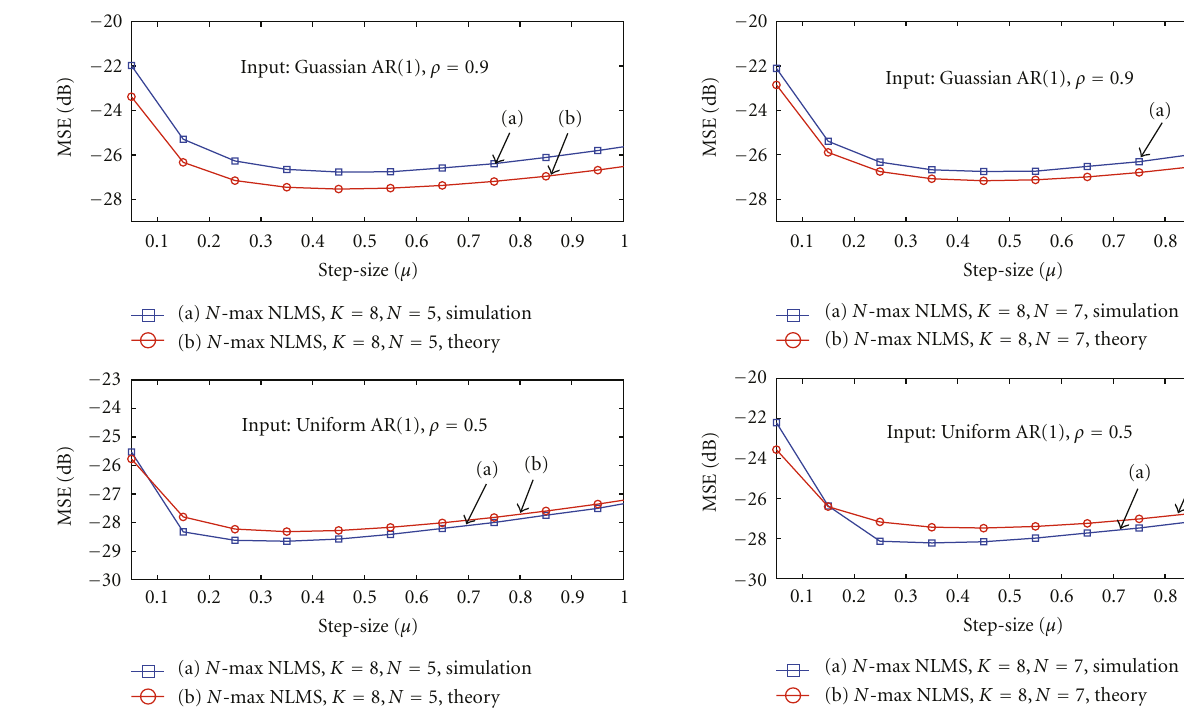
Figure 5: Steady-state MSE of N -Max NLMS with M = 8 and N = 7 as a function of the step size in nonstationary environment for di ff erent input signals.